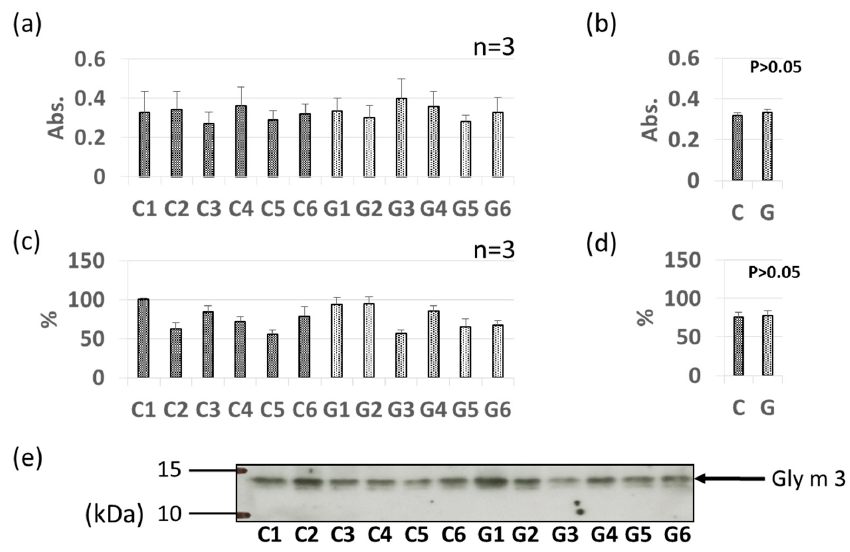
Figure 2. Comparison of Gly m 3 levels in GM-and non-GM soybeans by ELISA ( a , b ) and immunoblotting ( c – e ) using guinea pig-derived polyclonal antibodies. Soybean protein extracts were evaluated by ELISA ( a , b ) and immunoblotting ( c – e ) for detection of Gly m 3 levels. The ELISA data are presented in absorbance values (Abs). The individual data from six GM-and non-GM soybeans ( a , c ) are presented as the mean ± SD of three independent replicates. The collated data ( b , d ) are presented as the mean ± SD of all individual data points from the control (C1–C6, six non-GM soybeans) or experimental (G1–G6, six GM soybeans) groups relative to the value of control number 1 (C1). A representative immunoblot is also provided ( e ).